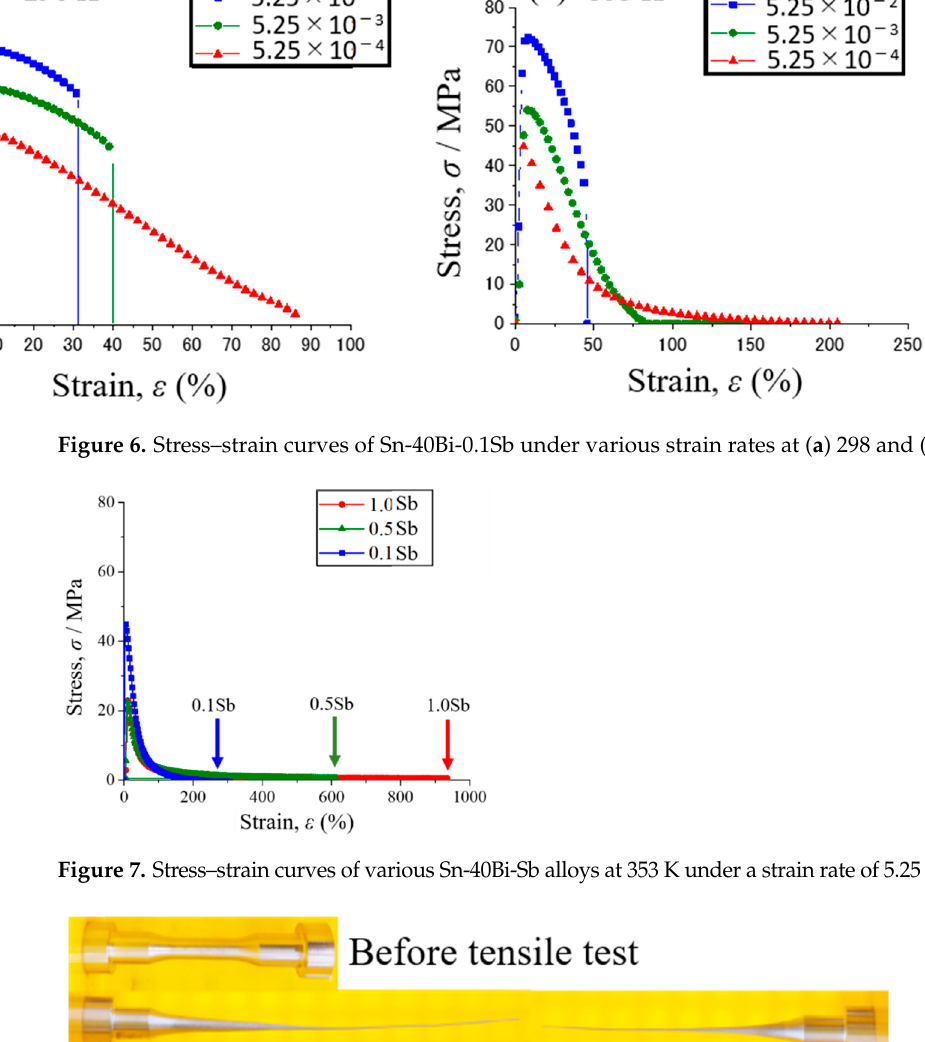
Figure 7. Stress–strain curves of various Sn-40Bi-Sb alloys at 353 K under a strain rate of 5.25 × 10 − 4 s − 1 . Figure 9. Fractured surface of the Sn-40Bi-1.0Sb alloy after the tensile test under a strain rate of 5.25 × 10 − 4 s − 1 at ( a ) 298 K and ( b ) 353 K. Figure 10 shows the stress–strain curves of Sn-40Bi-0.1Zn at various temperatures under a strain rate of 5.25 × 10 − 4 s − 1 . The ductility of Sn-40Bi-0.1Zn exhibited gradual im- provements as the temperature increased. The specimen showed superplastic defor- mation at temperatures above 333 K and elongation of up to 630%. Furthermore, speci- mens with different Zn concentrations demonstrated large elongations at 333 and 353 K. The Sn-40Bi-Zn alloys show the same temperature and strain-rate dependences as the Sn- 40Bi-Sb alloys (Figure 6); thus, the stress–strain curves in various conditions are omitted for this alloy in this paper. Figure 10. Stress–strain curves of Sn-40Bi-0.1Zn under a strain rate of 5.25 × 10 − 4 s − 1 at various tem- peratures. Figure 11 shows the stress–strain curves of the various Sn-40Bi-Zn specimens at 333 K, under a strain rate of 5.25 × 10 − 4 s − 1 . The elongation of the alloys increased in the order of 1Zn < 3Zn < 0.1Zn, likely because their microstructures were modified by Zn addition